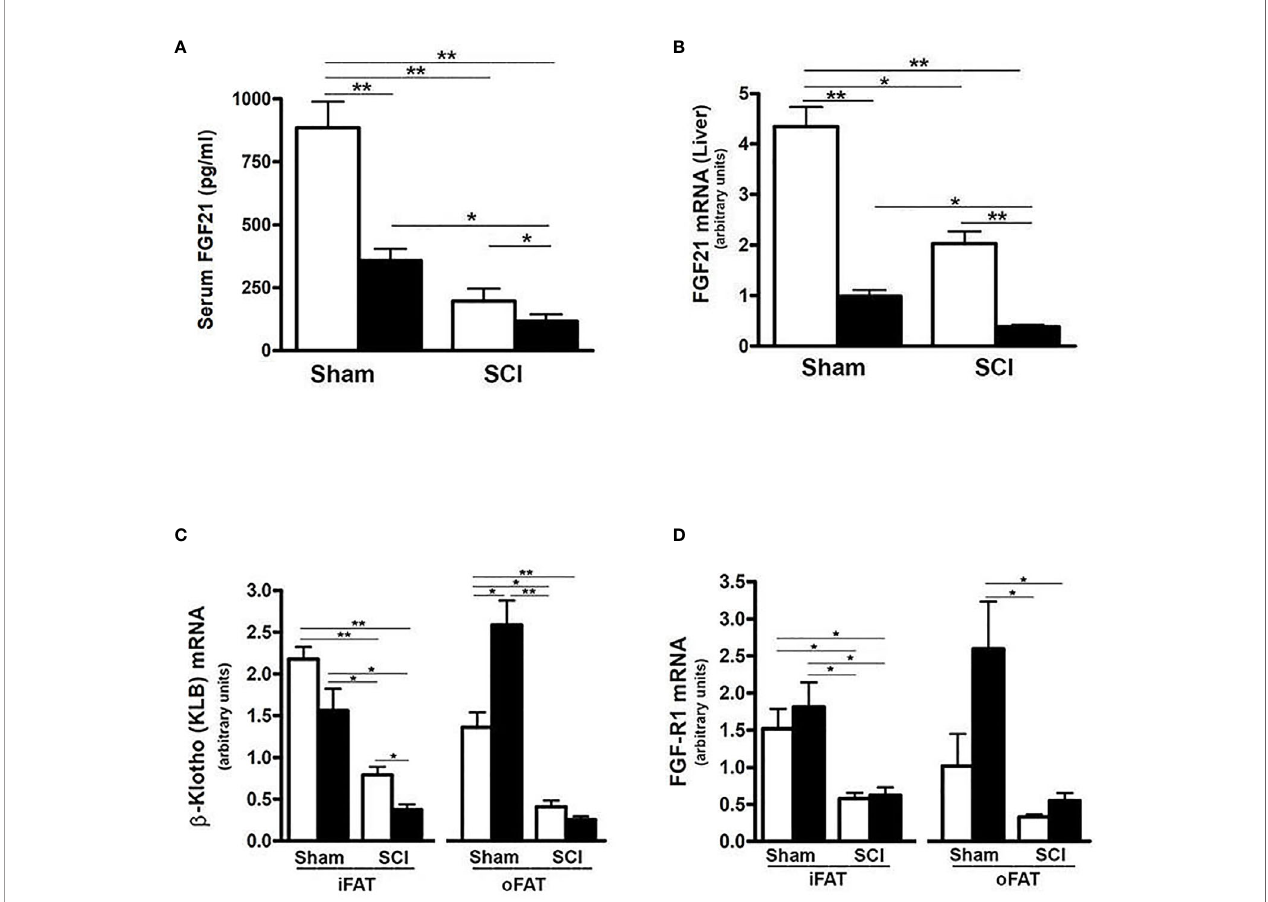
FIGURE 1 | SCI and high-fat diet (HFD) downregulated FGF21 signaling - Mice were fed with either ConD (White Bar) or HFD (Black Bar) after surgery. (A) , mouse FGF21 serum levels measured by ELISA. (B) , hepatic FGF21 mRNA expression by Rt-PCR. (C) , KLB mRNA expression in mouse adipose tissues by Rt-PCR, and (D) , FGFR1 mRNA expression in mouse adipose tissues by Rt-PCR. Data shown are mean values ± SEM (n = 5). * p < 0.05; ** p <